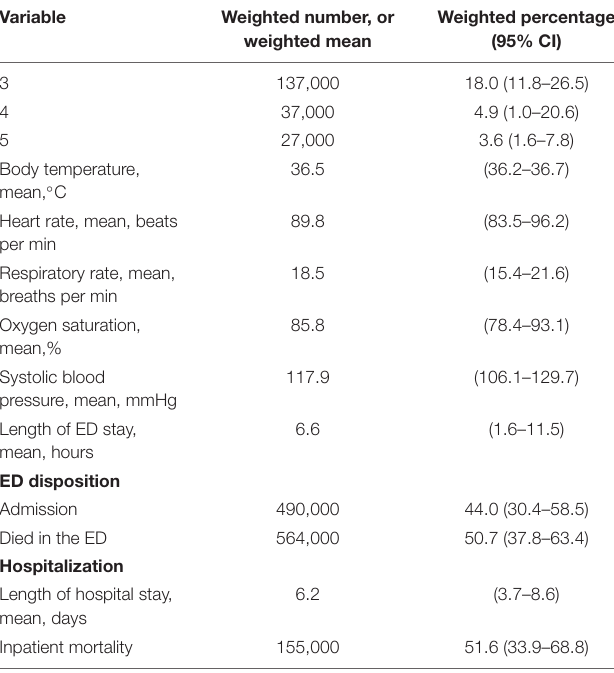
Frontiers in Cardiovascular Medicine |